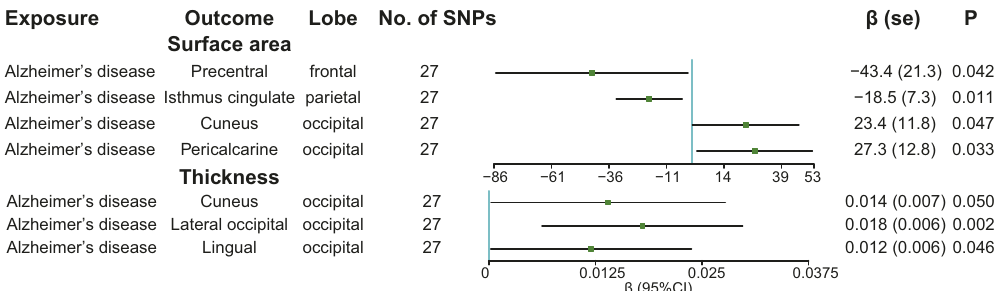
Fig. 4 The causal effect of genetically predicted Alzheimer ’ s disease on cortical structure. SNP single-nucleotide polymorphism, β changes in cortical thickness in population with the disease compared with controls, SE standard error, CI con fi dence interval, IVW inverse-variance